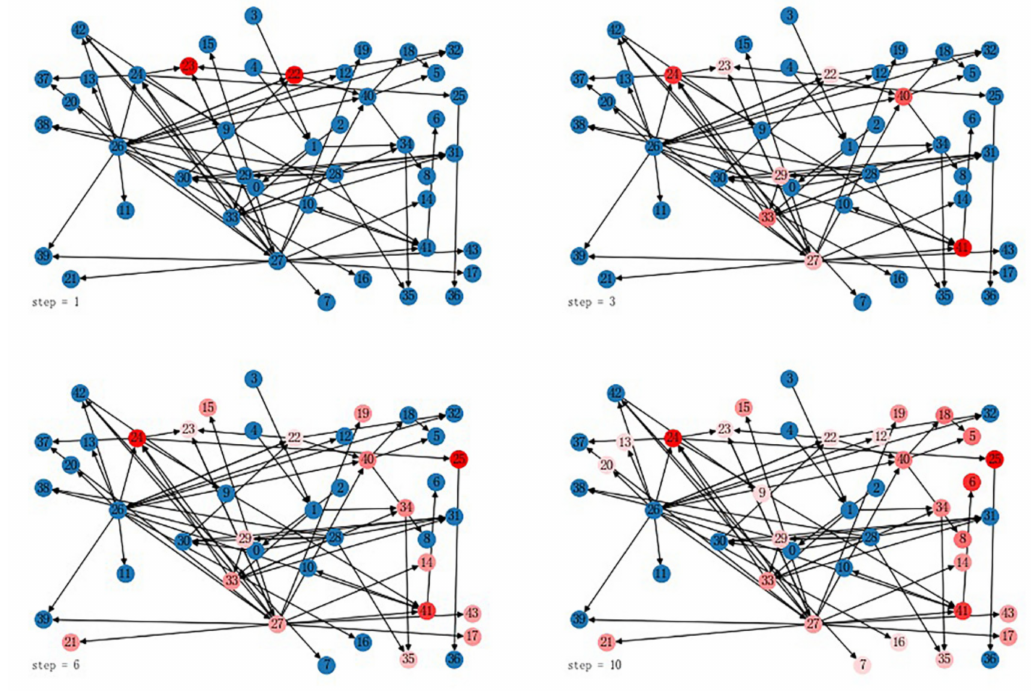
Figure 10. Single assembly error probability propagation process.